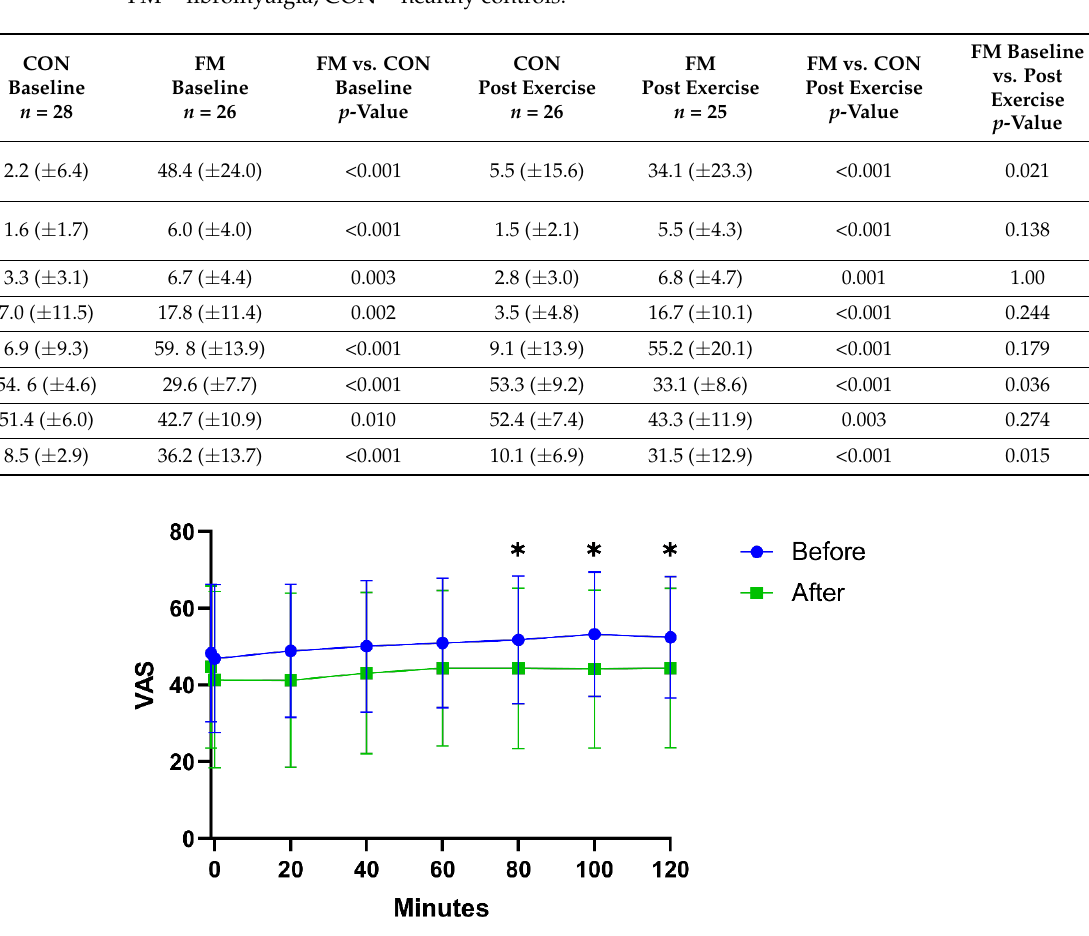
Figure 1. Pain intensity (VAS 0–100) during microdialysis in the vastus lateralis muscle in fibromyalgia patients before and after 15 weeks of resistance exercise intervention. There were significant (*) decrease in VAS at 80, 100, and 120 min after intervention.